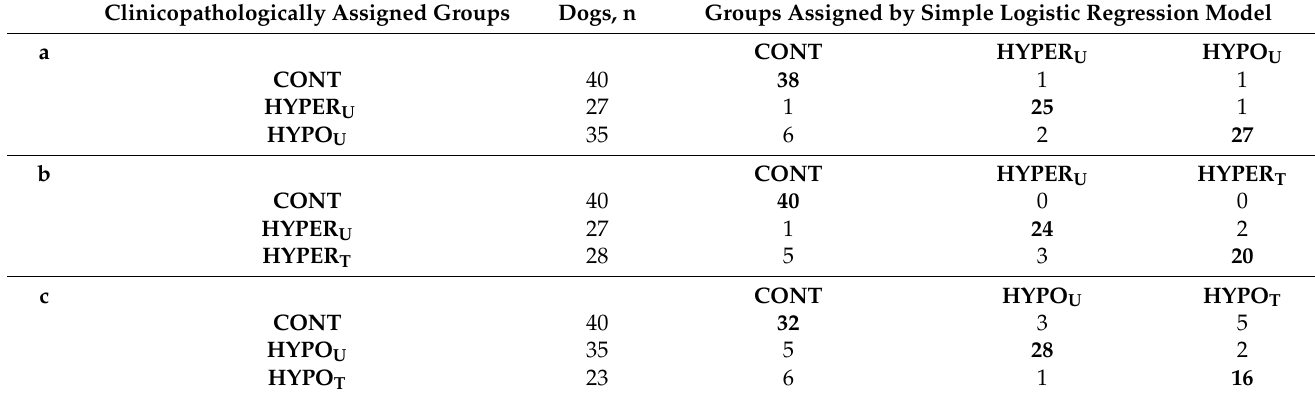
Table 2. Simple logistic regression model to classify dogs based on the metabolomics data into the groups of (a) HYPER U , HYPO U , and CONT, (b) HYPER U , HYPER T , and CONT, (c) HYPO U , HYPO T , and CONT compared to the clinicopathologically assigned groups.